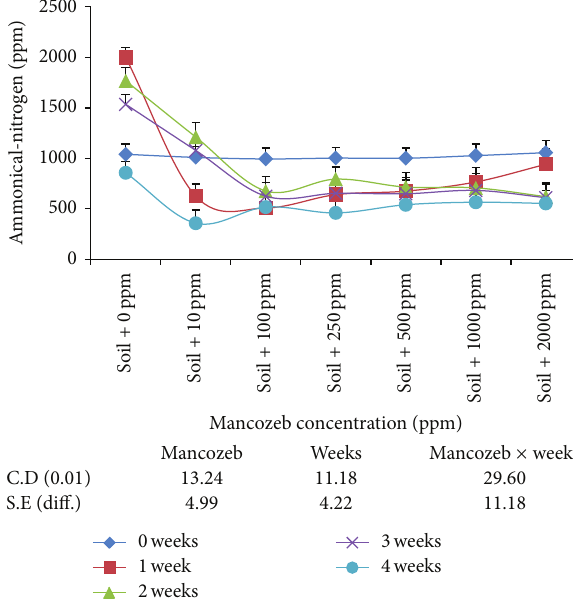
Figure 3: Effect of mancozeb on ammonification of 500 ppm of peptone applied to soil.